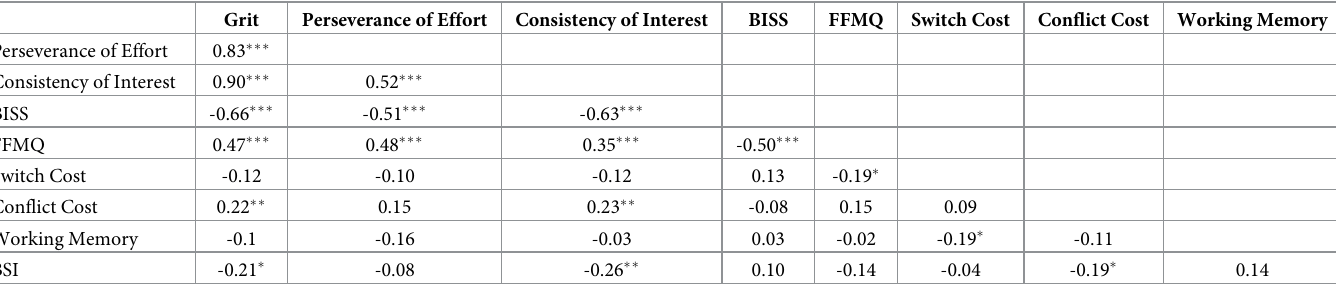
Table 2. Spearman correlations between the main variables.